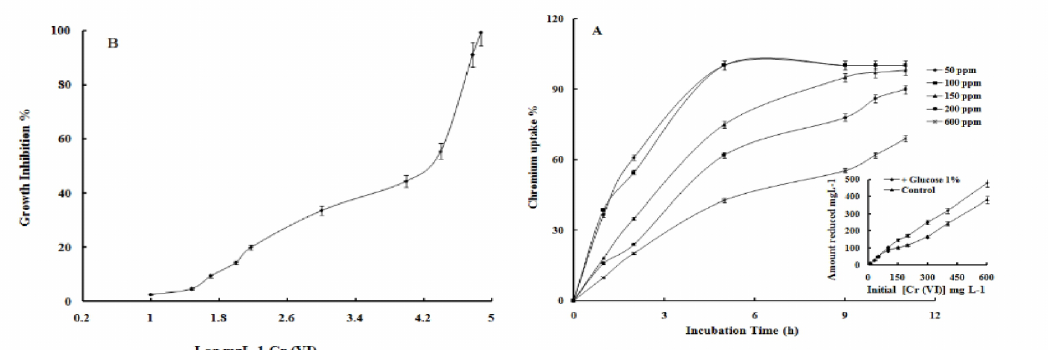
Fig. 1. (A) The effect of [chromium] on Cr(VI) reduction at 37 ºC, pH 7.0, and glucose (1%). Inset: amount of Cr(VI) reduced after 10 h in the absence (control) and presence of an electron donor, such as glucose (1%) with varying initial Cr(VI) concentration. (B) Inhibition of growth in CKCr-6A strain in the presence of different concentrations of Cr(VI) upto 100,000